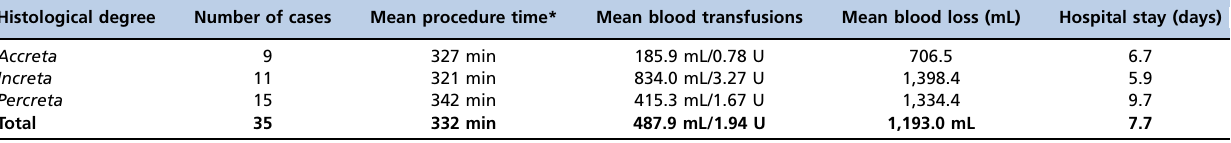
*= Time from the beginning of anesthesia to the end of the abdominal wall closure. Table 3 - Mean cumulative blood loss volume from all endovascular procedures.* Technique